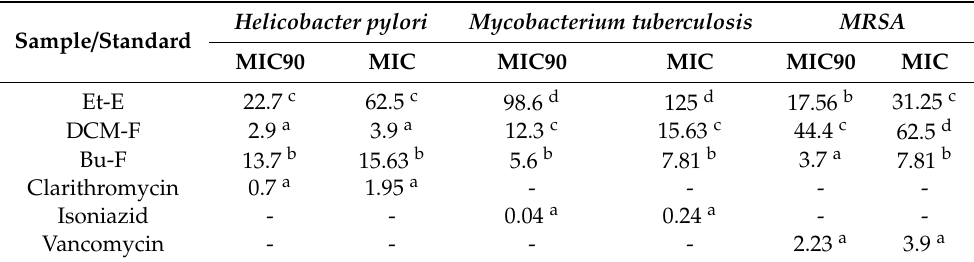
Table 3. Antibacterial activity of Hibiscus schizopetalus.